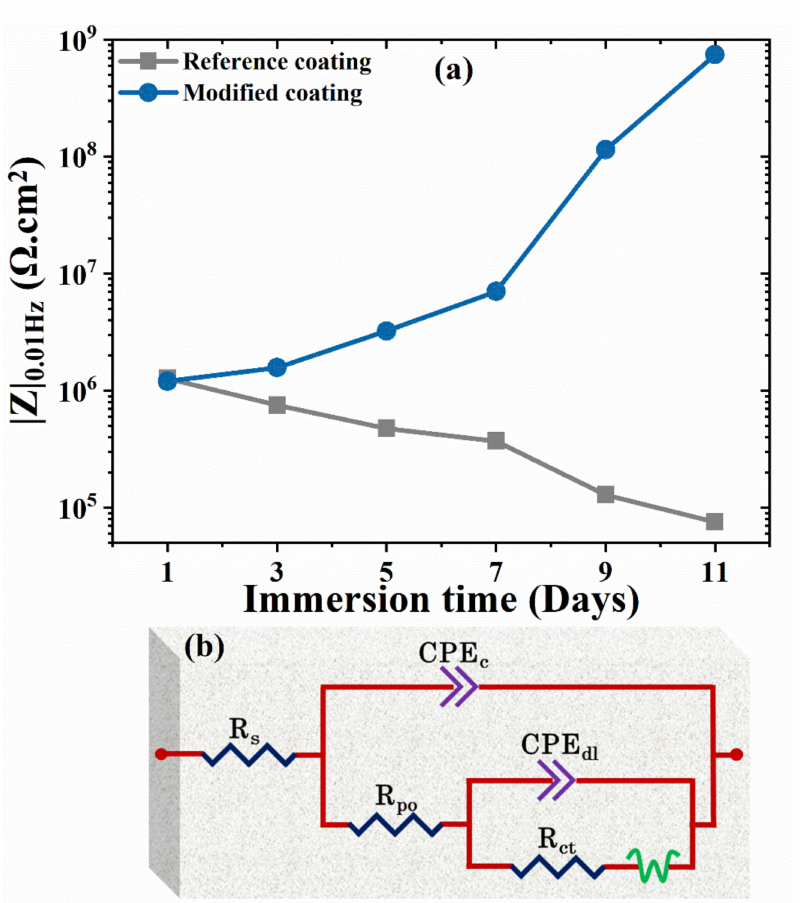
Figure 7. ( a ) Low impedance values for reference and modified coating; ( b ) equivalent circuit. The values of relevant EIS parameters, namely solution resistance inside pores and scratch (R po ), faradic resistance (R ct ), and respective constant phase elements (CPE c , CPE dl ) were obtained after fitting with the equivalent circuit provided in Figure 7b and Table S1. The high frequency capacitive slope corresponds to the coated areas and its constant phase element, while the low frequency time constant, R ct and CPE dl , can be assigned to the surface activity in the scratched areas and bottom of the pores. The EIS fitting values are depicted in Figure